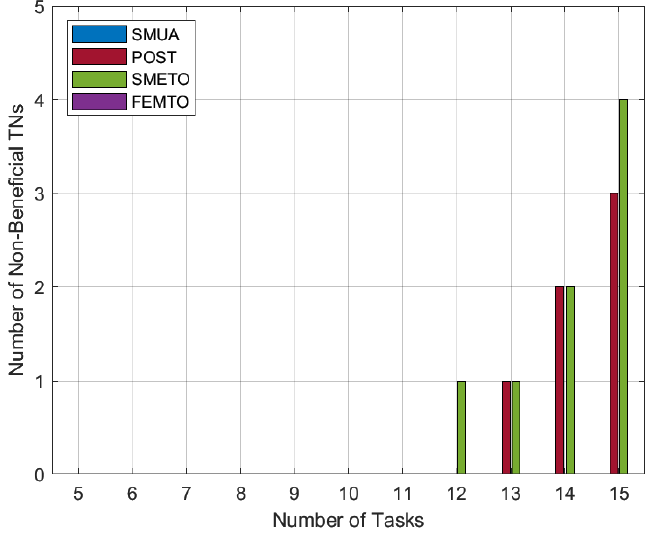
Figure 4. Non-beneficial TN